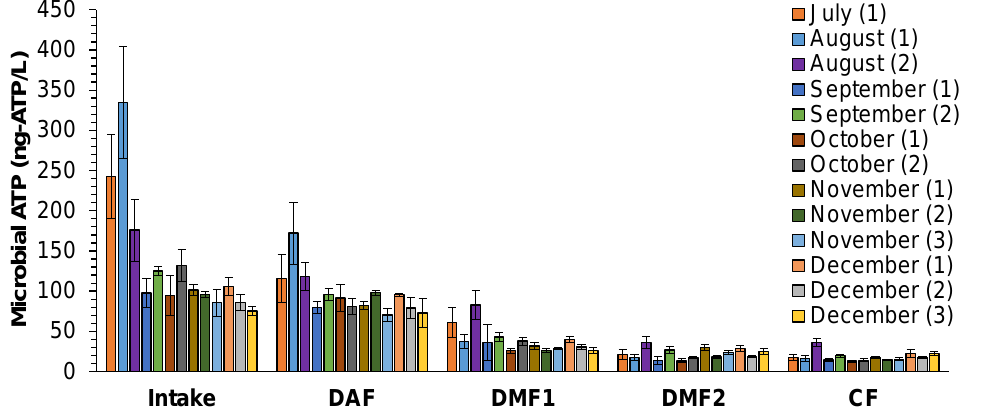
Figure 2. Microbial ATP concentrations in the SWRO pre-treatment train over a 5 month period (n = 13). DAF (dissolved air flotation), DMF1 (the first stage of dual media filtration), DMF2 (the second stage of dual media filtration) and CF (cartridge filtration). The number mentioned in the legend refers to the batch of samples collected in the month.